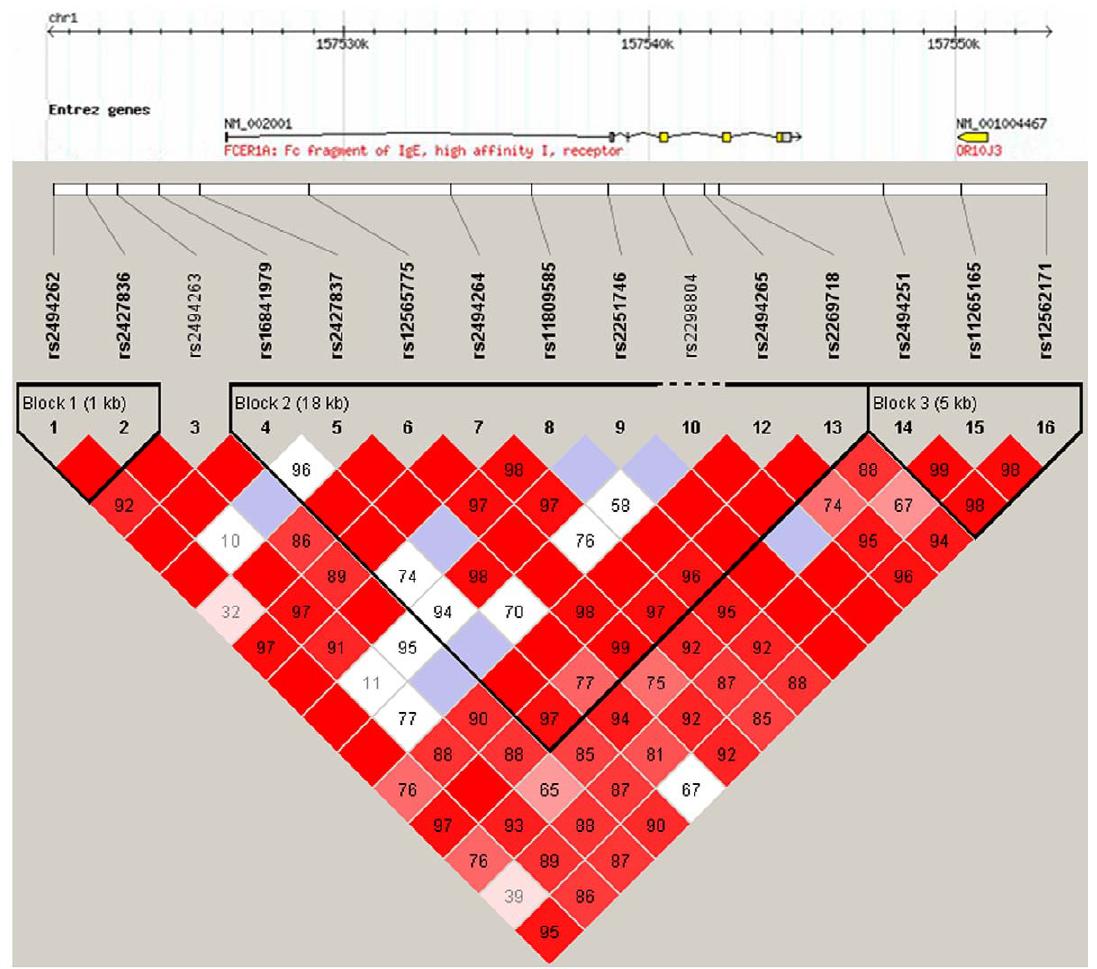
Figure 1. Pairwise Linkage Disequilibrium (LD) between tagging SNPs for the FCER1A gene. The LD plots were generated by Haploview 4.1. The white horizontal bar below the info track illustrates the location of SNPs on a physical scale. The value within each diamond represents the pairwise correlation between tagging SNPs defined by the upper left and the upper right sides of the diamond. Shading represents the magnitude and significance of pairwise LD, with a red-to-white gradient reflecting higher to lower LD values.